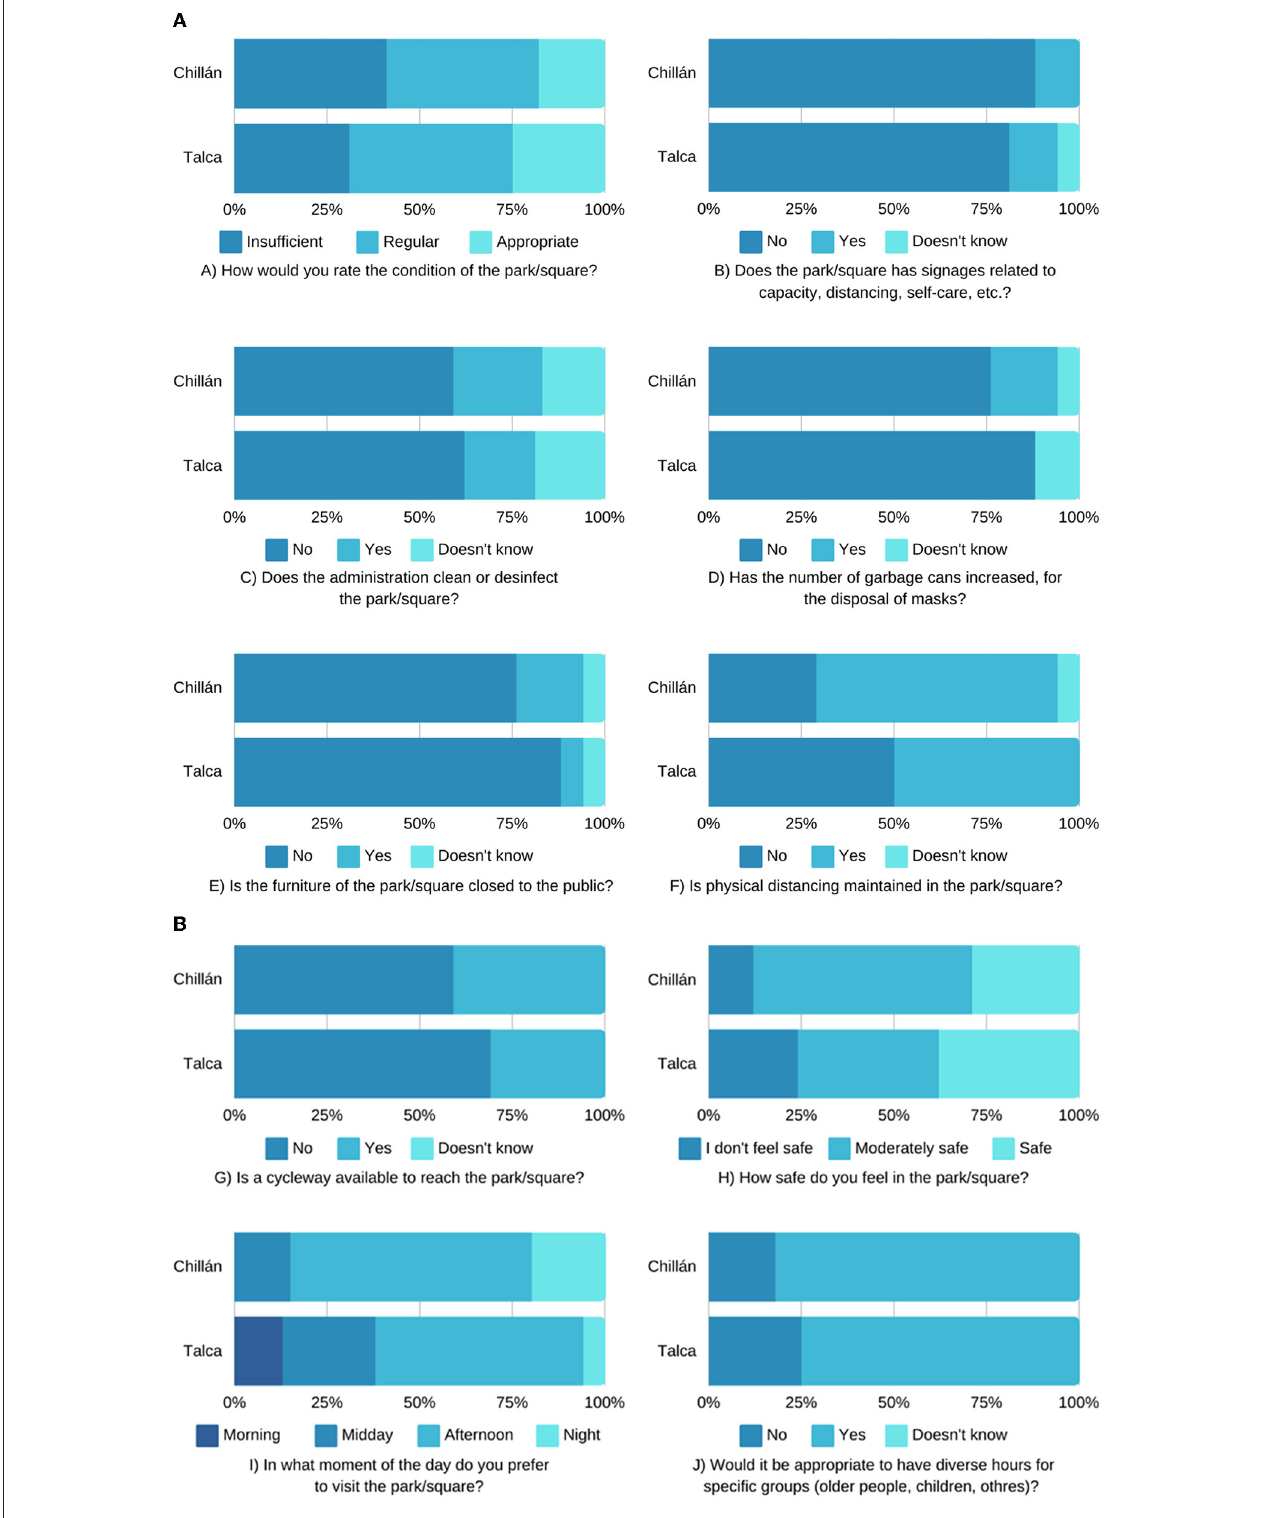
FIGURE 7 | (A) Statistical evaluation of survey responses, questions A to F. (B) Statistical evaluation of survey responses, questions G to J.